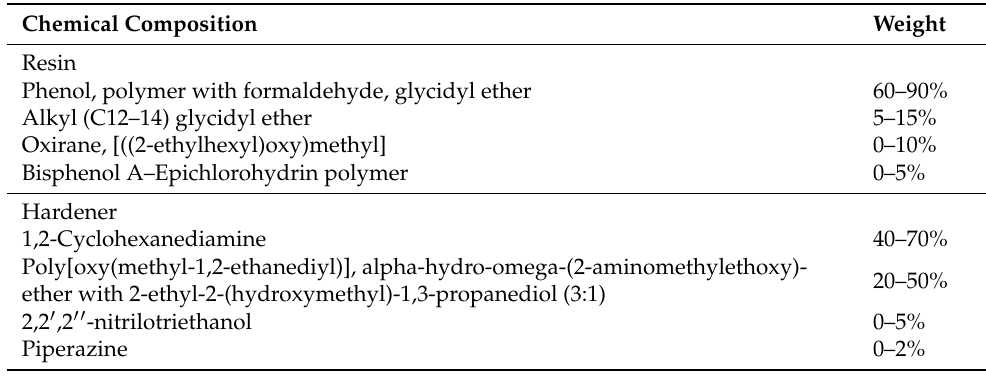
Table 1. Chemical composition of resin and hardener used for sealing Nb